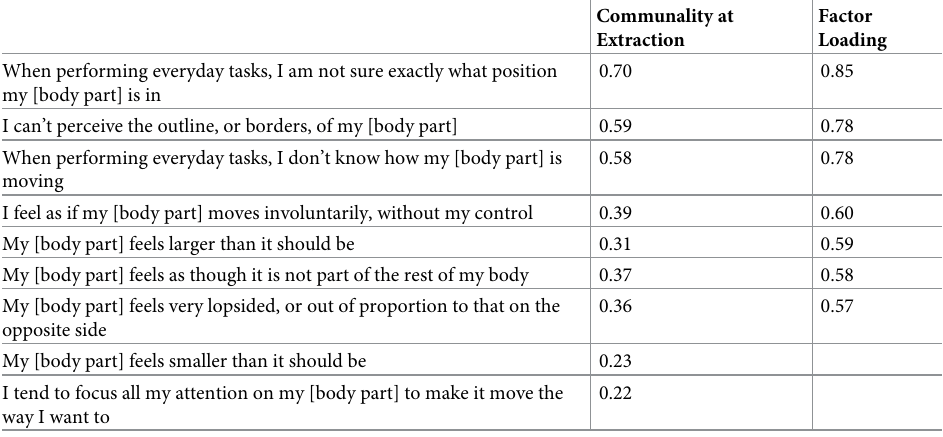
Table 3. Communalities at extraction of the original 9 items of the FreBAQ-general, and principal axis factoring- based loadings of the retained 7 items. Items are displayed in order of decreasing factor